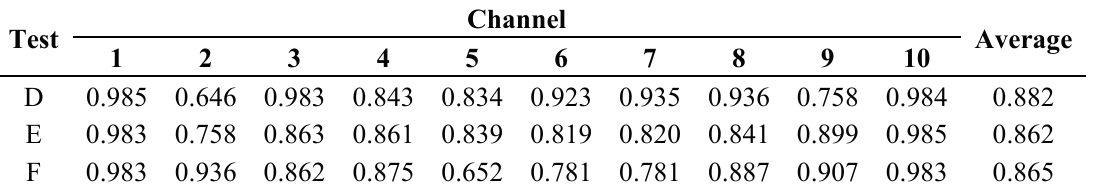
Table 4. Coefficient of determination for test sensor ( i.e. , alginate with fibroblasts).